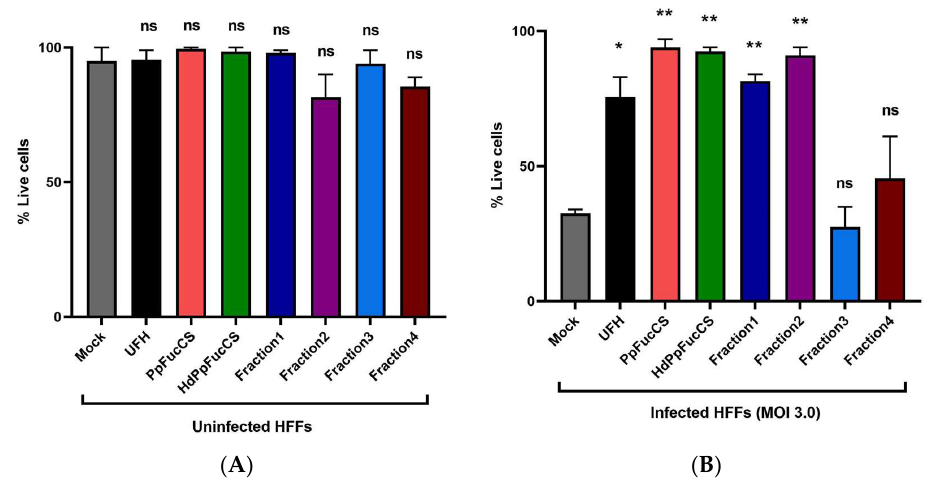
Figure 4. Effect of treatment of PpFucCS and its oligosaccharides on cell viability of HFF cells. The primary HFF were pretreated for one hour using PpFucCS and its oligosaccharides at the highest concentration used for inhibition assays (50 µg/mL) along with heparin (UFH) control. The HFFs were either mock infected ( A ) or infected with HCMV at a MOI of 3.0 ( B ) in the presence of test compounds. Cells were harvested at 5 days post-infection and cell viability was assessed using a trypan blue exclusion assay. The results are representative of two independent experiments. The standard error of the mean was plo(cid:308)ed as error bars. The **, *, and ns indicate p -value between 0.001 and 0.01, between 0.01 and 0.05, and ≥0.05, respectively.